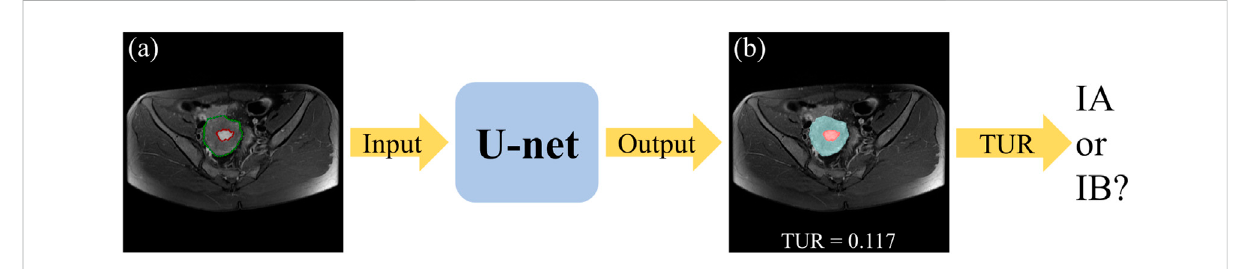
FIGURE 1 The fl owchart of the automatic staging model based on DL. The original MRI image (A) , where the red outline is the ground-truth of the tumor and the green outline is the ground-truth of the uterus. A blend of the predicted segmentation map of the U-net and the original MRI image (B) , where the red area is the tumor and the blue area is the uterus.